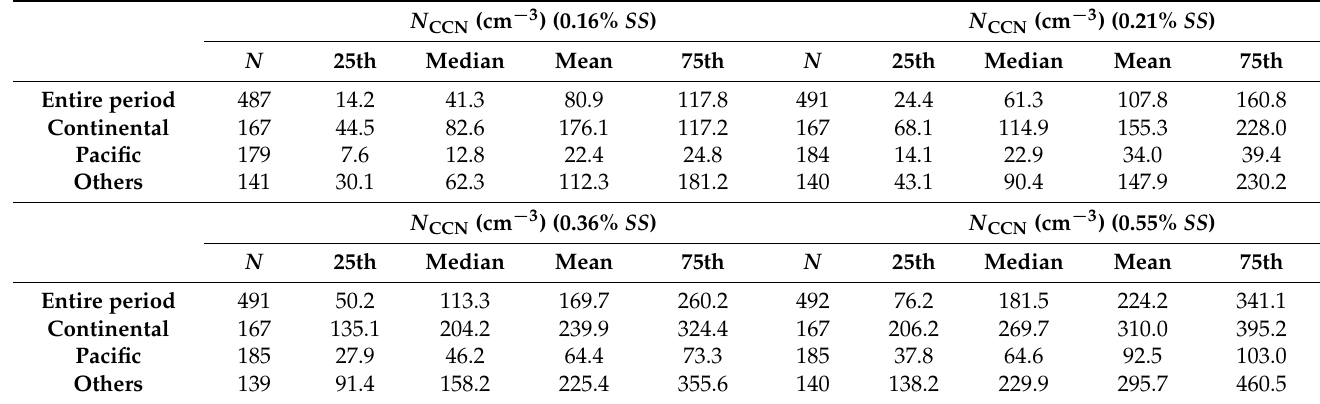
Table 2. The 25th percentile, median, mean and 75th percentile values of N CCN at each SS . Number of data ( N ) for each air mass category is also